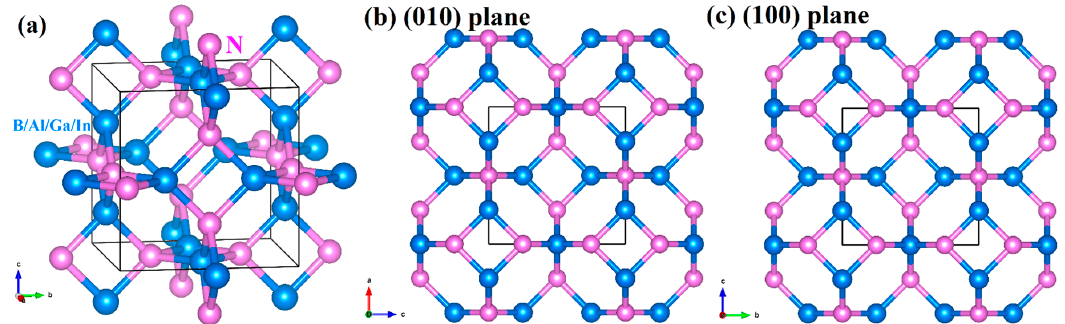
Figure 1. The crystalline structures of Pm − 3 n XN (X = B, Al, Ga, In) ( a ), along the (010) direction ( b ) and the (100) direction ( c ). Table 1. The lattice constants (Å), volumes of the conventional cell (Å 3 ), elastic parameters (GPa), B , G , E (GPa) and Poisson’s ratio v of Pm − 3 n XN and c-BN.